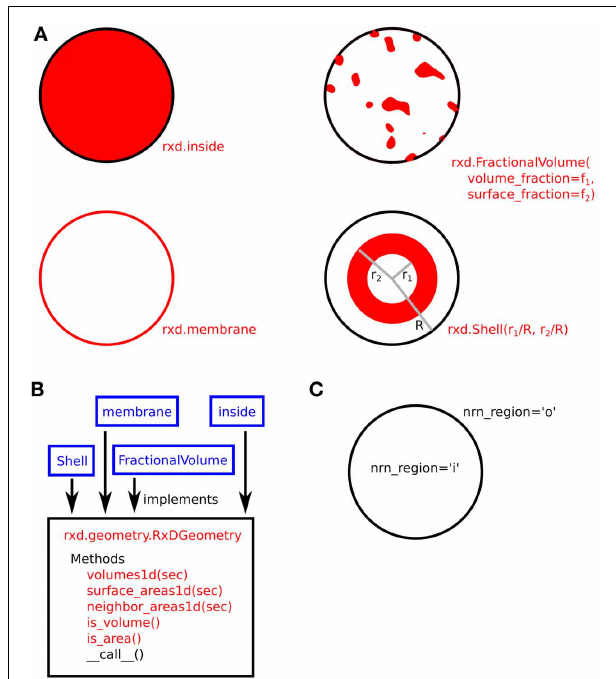
FIGURE 3 | (A) Four examples of compartment geometry supported by rxd . In NEURON, the dendritic cross-section is approximated as a circle. The red colored areas correspond to the portion of the cross-section described by the given geometry. FractionalVolume is the most general and is intended for cases where the region occupies a complexly-shaped subset of the cross-section. (B) These classes (blue) implement the rxd.geometry.RxDGeometry interface; users may extend rxd with new geometries by writing new classes that implement the same interface. (C) Named Species (e.g., ca ) living in a Region with nrn_region='i' map to concentrations in NMODL’s inside region (e.g., cai ). Similarly, 'o' maps to NMODL’s outside region.